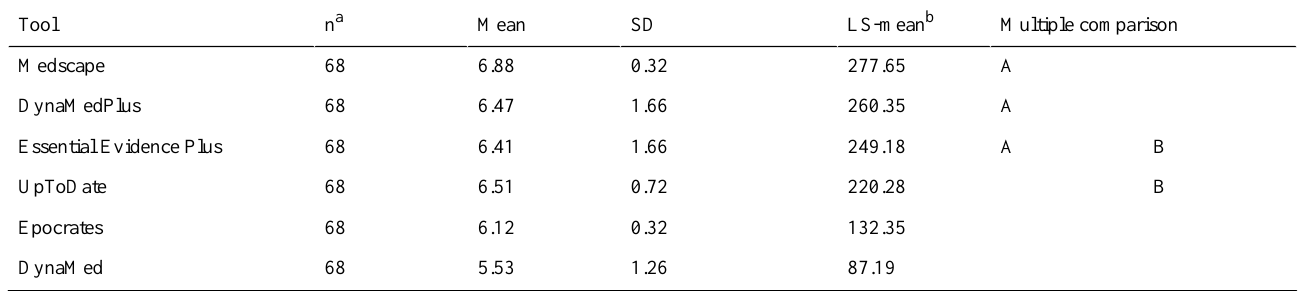
Table 1. Breadth of coverage among six point-of-care